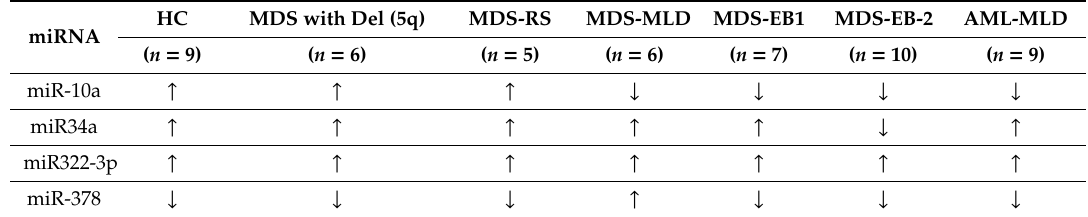
Table 2. Expression Profile of Selected miRNAs in MDS Subtypes and